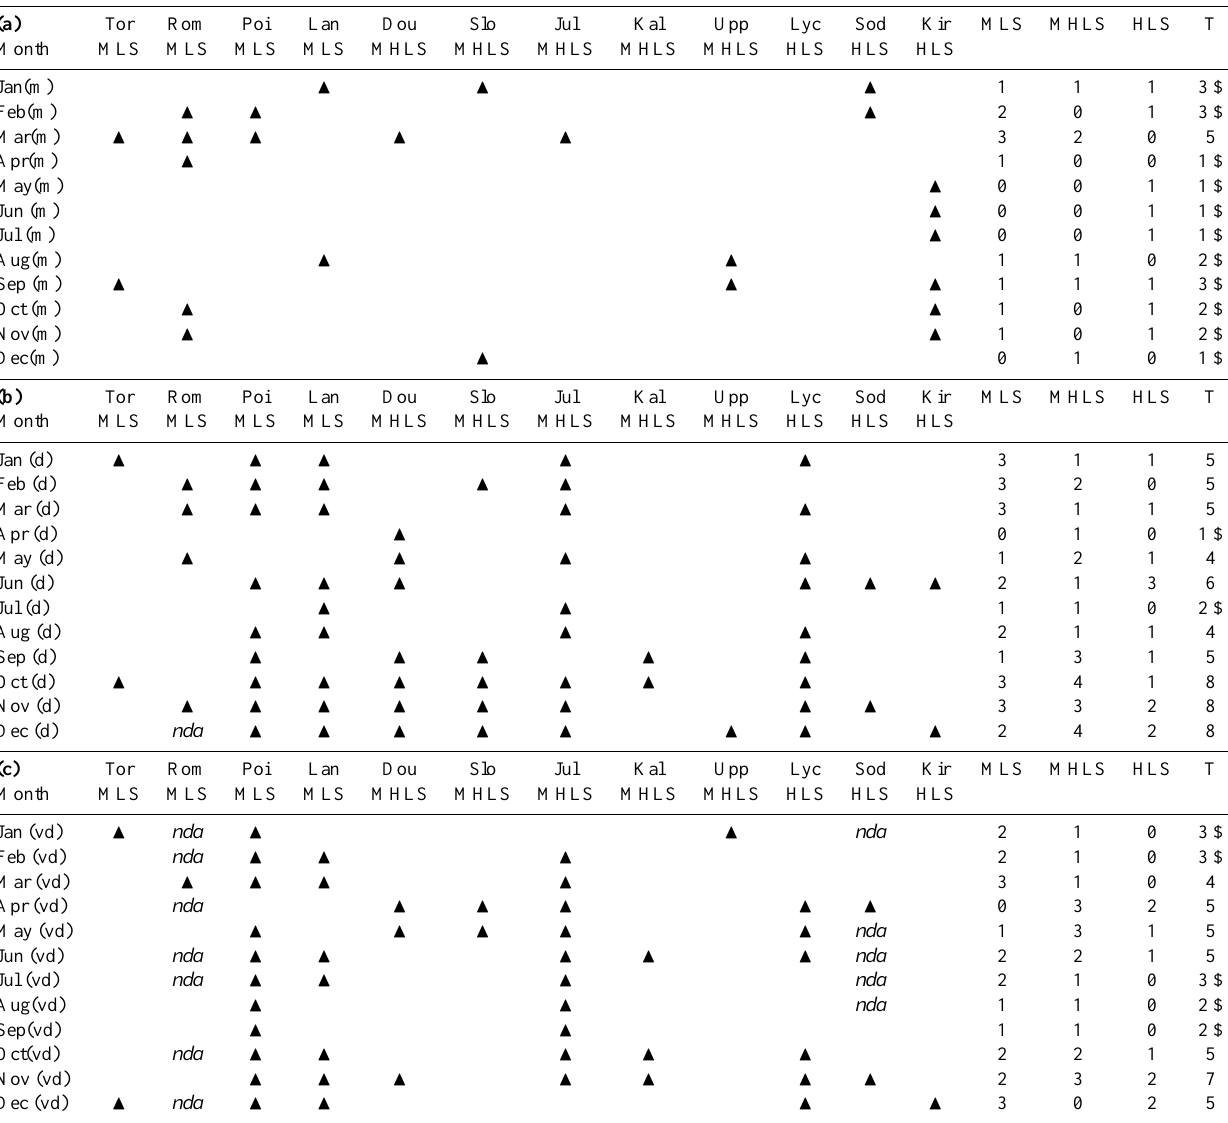
Table 3. Same as Table 2 but for the sites where the best performance is provided by the prediction model (4), indicated with the triangle. The term nda indicates the cases for which it was not possible to evaluate the performance of the prediction model (4) with respect to the other models because no data were available to calculate the g.r.m.s.